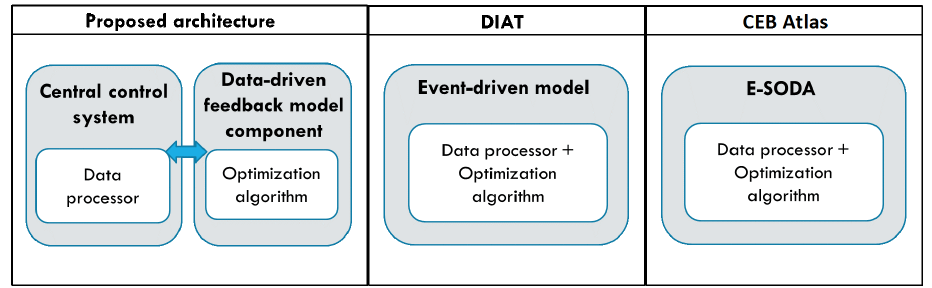
Figure 15. Data-driven function flexibility comparison between proposed architecture, DIAT and CEB